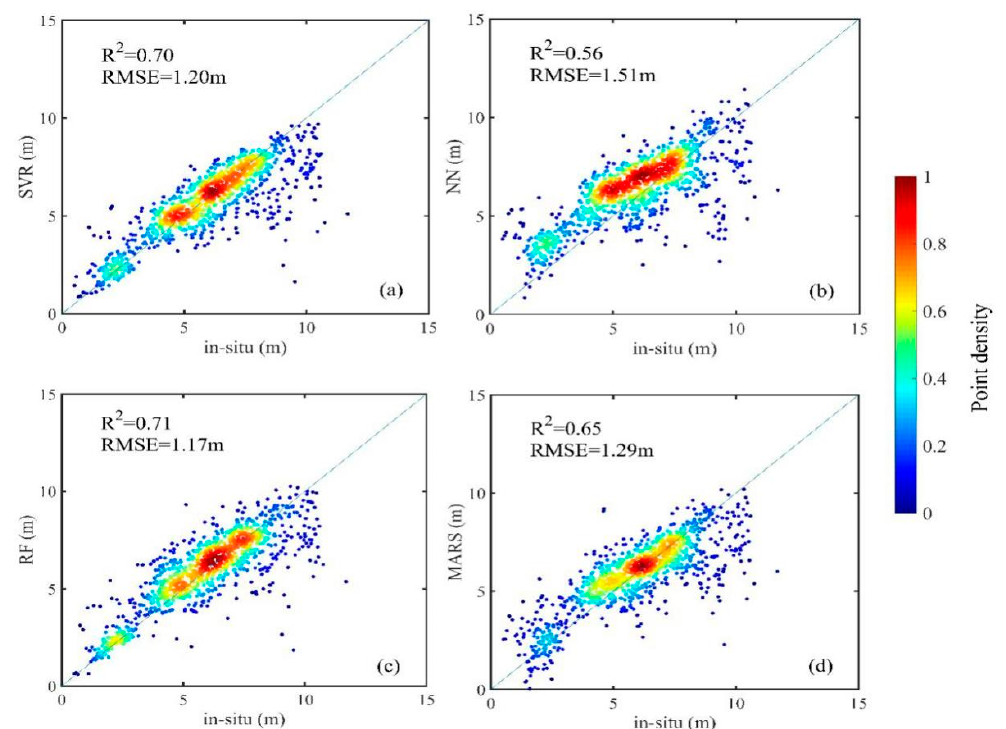
Figure 3. Correlation between the in-situ depths and the water depth estimation results based on one training set of satellite image data and one machine learning method: ( a ) support vector regression (SVR); ( b ) neural networks (NN); ( c ) random forests (RF); ( d ) multi-adaptive regression splines (MARS).